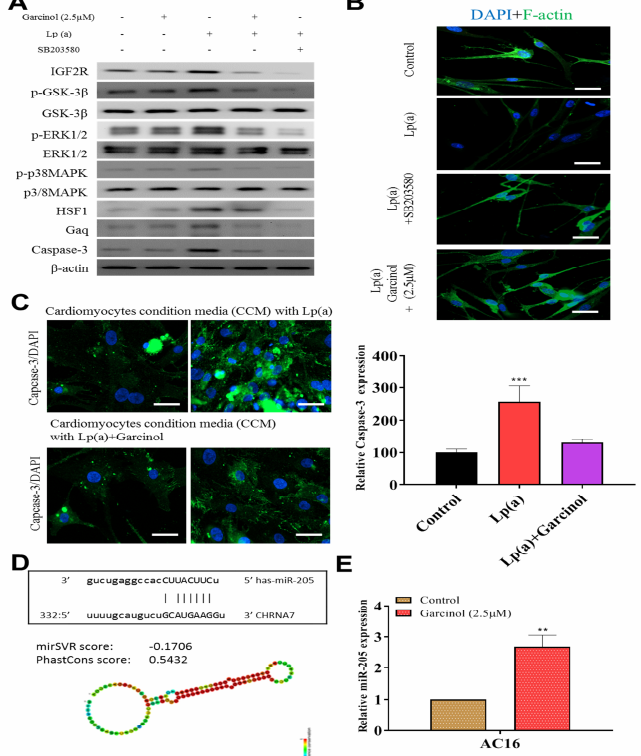
Figure 5 Figure 5. Garcinol prevented apoptosis and inhibited insulin-like growth factor-II receptor (IGF2R) through inactivation of phosphorylation of GSK-3 β /ERK/p38 MAPK in ventricular cardiomyocyte AC16 cells. ( A ) Western blot analysis revealed that Lp(a) upregulated the expression of MAPK signaling-related proteins including p-GSK-3 β , p-ERK1/2 and p-p38 MAPK. Garcinol significantly inhibited the Lp(a)-induced phosphorylation of GSK-3 β , ERK1/2 and p38 MAPK, but had no obvious effect on total ERK1/2 and p38 MAPK expression. ( B ) In the immunofluorescence analysis of F-actin polymerization, nuclei and F-actin were stained, respectively, with 4 (cid:48) ,6-diamidino-2-phenylindole (DAPI, blue) and rhodamine-phalloidin (red orange). An overlay of the two fluorescent signals was shown (scale bars = 20 µ m). ( C ) Left panel: representative images of caspase-3 activation in AC16 cells treated with cardiomyocytes condition media in the presence of Lp(a) for 24 h with and without garcinol. Right panel: quantification of relative caspase-3 activation. A substantial reduction in caspase activation, suggesting less apoptosis, was observed in garcinol treatment in comparison to Lp(a) only treatment. ( D ) The mir-Target prediction showed the 3 (cid:48) UTR sites of CHRNA7 targeted by miR-205. ( E ) qPCR analysis showed miR-205 expression was significantly upregulated by garcinol in comparison to control. * p < 0.05, ** p < 0.01, *** p <